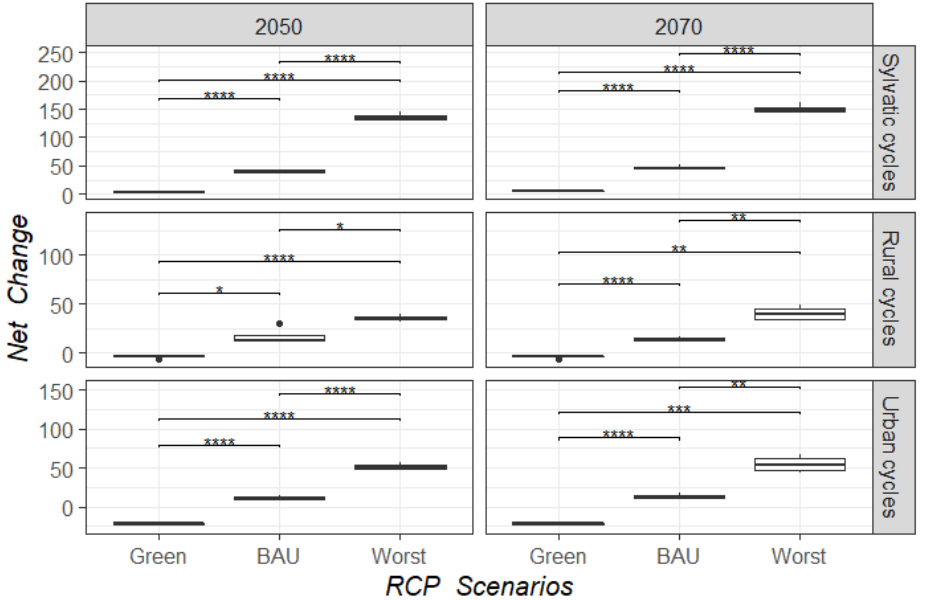
Figure 6. Net change of range shift for each type of T. cruzi transmission cycle under future LUCC-CC scenarios. The significance levels ( p -values) for the differences between the average values of net change of the four GCMs in each RCP is indicated by asterisk(s) above the boxes: **** p <0.0001, *** p <0.001, ** p <0.01, * p <0.05, based on t testing.